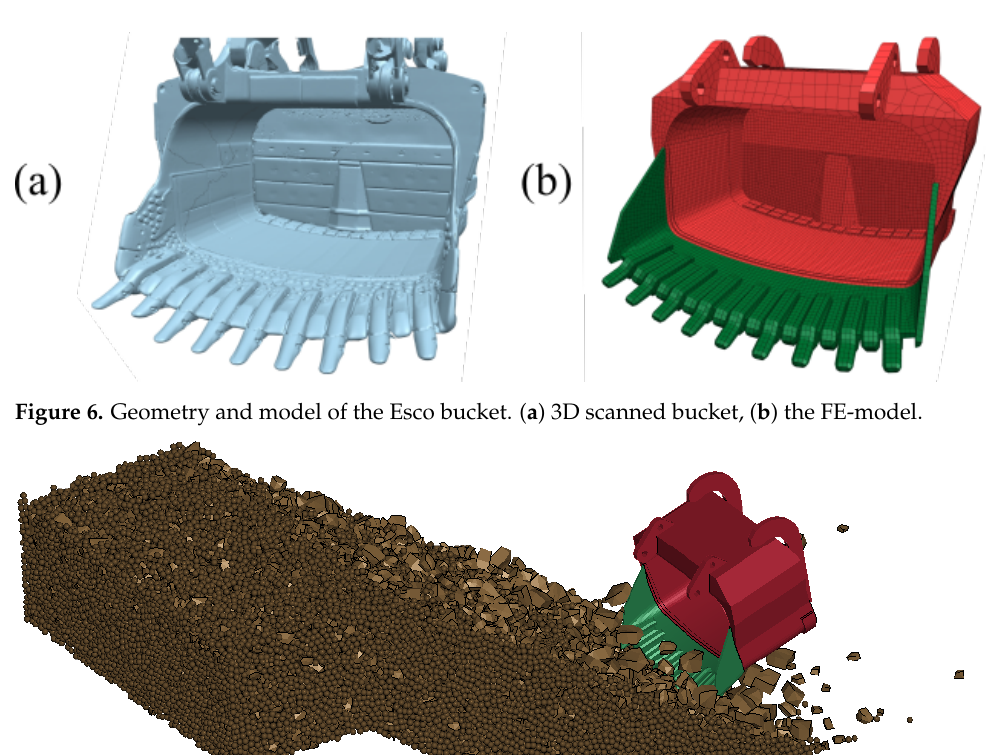
to simulate one bucket filling corresponding to approximately 38 s was approximately 8 h. simulations time was approximately 80